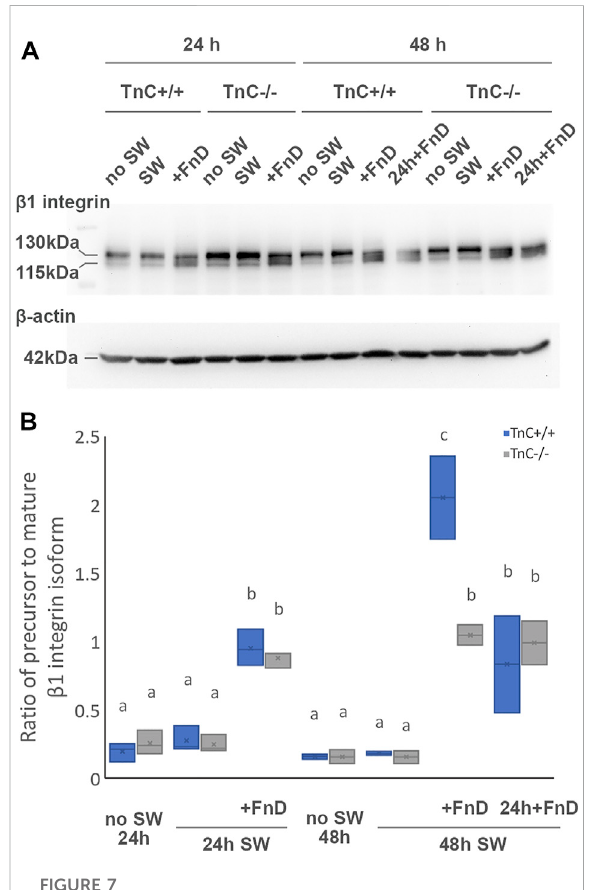
FIGURE 7 FnD treatment increases the ratio of precursor to mature β 1 integrin isoform. Representative Western blot image is shown for β 1 integrin and respective β -actin (A) . Box — whisker plots of ratioofprecursortomature β 1integrinisoformareshown (B) . Two-way ANOVA was used to test statistical signi fi cance. Pairwise comparisons are denoted with letters, shared letters imply no signi fi cant difference between groups. Actual p values are indicated in the text ( n = 3 independent cultures).